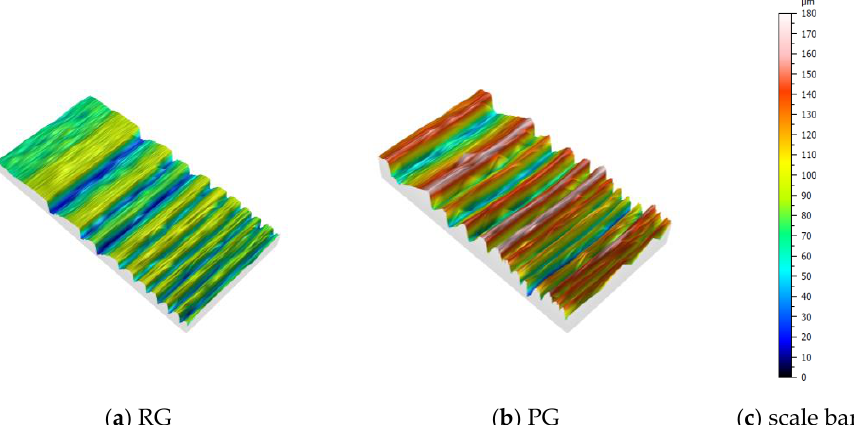
Figure 9. Fillet radius morphology of ( a ) real and ( b ) prototype geometry with ( c ) scale bar.